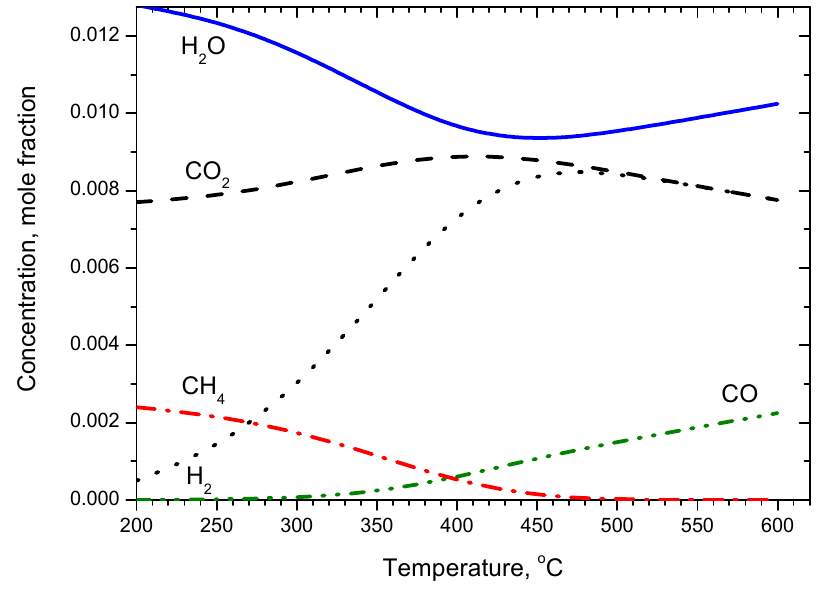
Figure 5. The effect of the temperature on equilibrium gas composition (in mole fraction) for the feed 0.01 CO + 0.018 H 2 O in He.